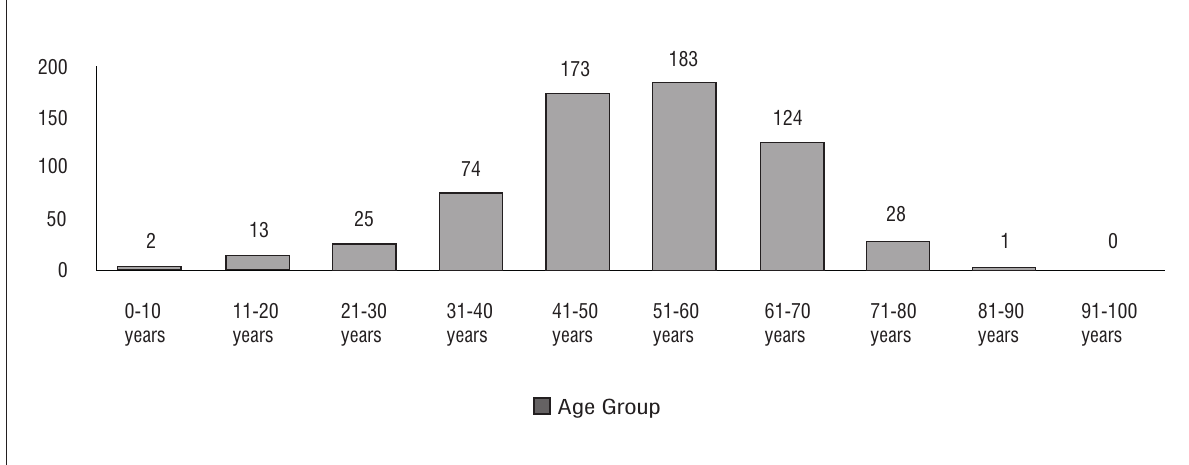
Table 1 - Main pathologies treated in the physiotherapy public sector in Boa Vista do Cadeado city – Rio Grande do Sul state Pathologies N % Marginal ostheophytes in the lumbosacral spine 76 12% Degenerative disc disease in the lumbosacral spine 62 Tendinopathy in the shoulder Marginal Osteophytes in the lumbar spine Shoulder bursitis Degenerative Disc Disease in the cervical spine Shoulder Arthrosis Herniated Disc in the lumbosacral spine